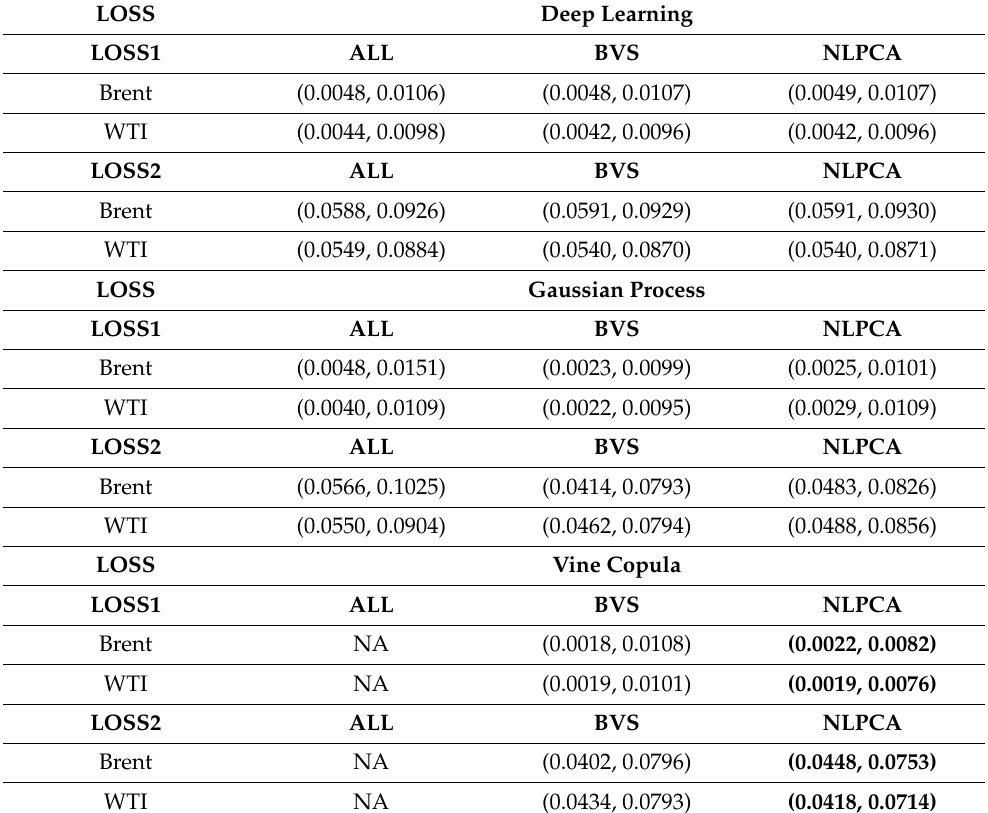
Table 7. The 95% Confidence Interval for the Loss functions (LOSS1 and LOSS2) of BRENT and WTI log return